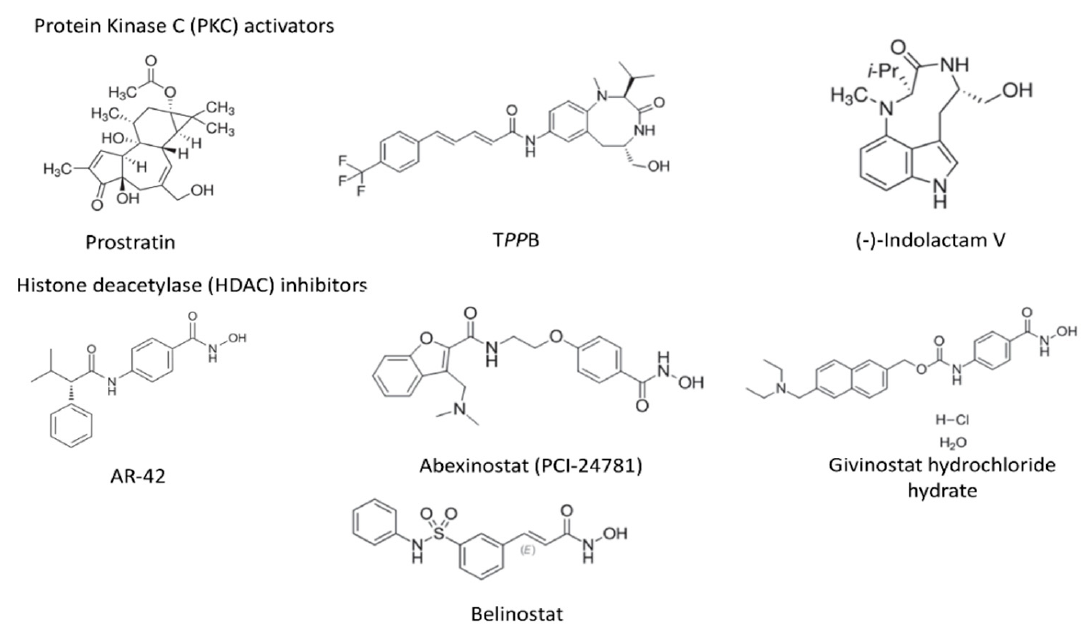
Figure 1. Chemical structure of latency-reversing agents (LRAs). Table 1. Evaluation by dose response of HIV activation (EC 50 ) using ELISA (OM-10.1, U1, and ACH-2 cells) and GFP expression (J-Lat 10.6 and J-Lat A2 cells) and cytotoxicity (CC 50 ) of LRAs after 48 h treatment.